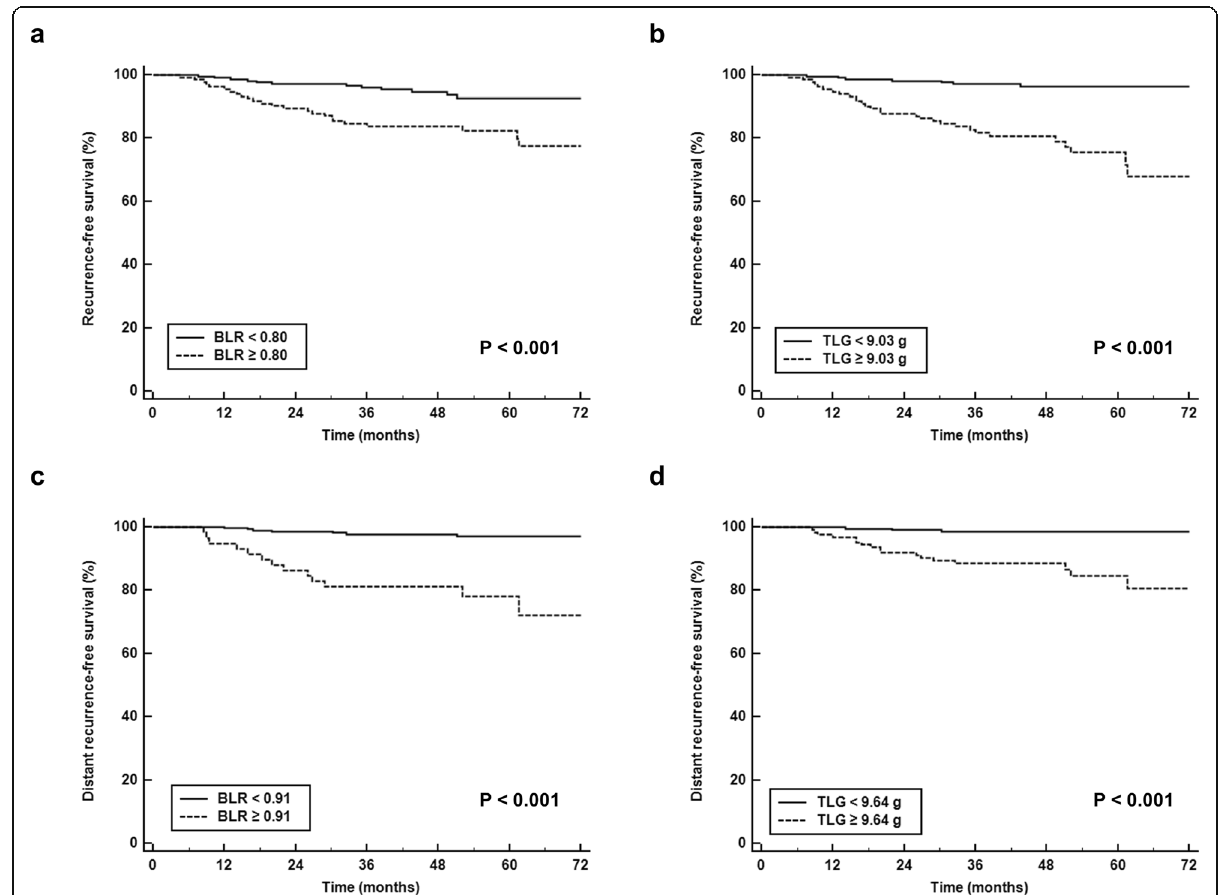
Fig. 3 Recurrence-free survival stratified by bone marrow-to-liver uptake ratio (BLR) ( a ) and total lesion glycolysis (TLG) of primary breast cancer ( b ). Distant recurrence-free survival stratified by BLR ( c ) and TLG of primary breast cancer ( d )